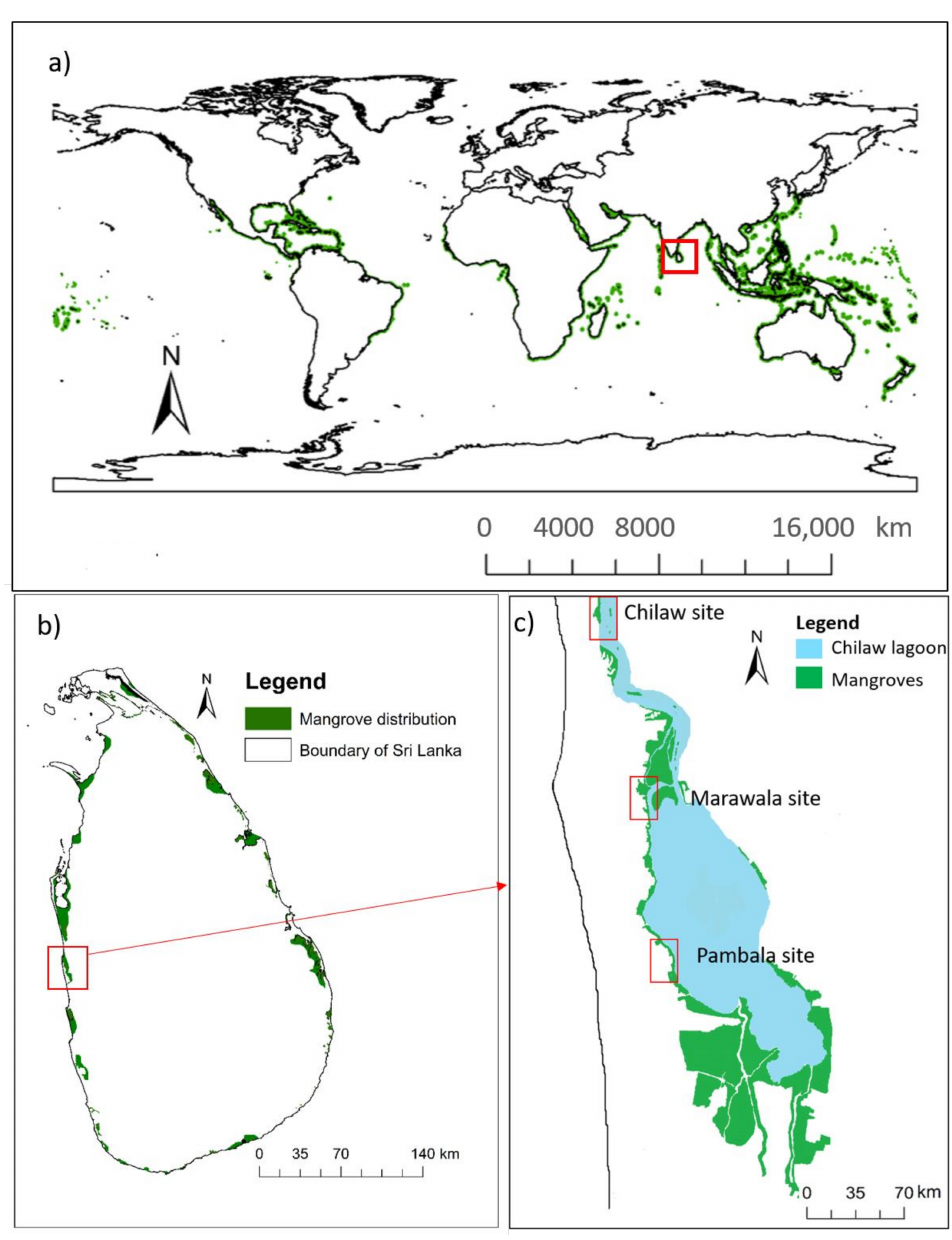
Figure 1. ( a ) Worldwide mangrove distribution [30] showing the location of Sri Lanka in the red colour square; ( b ) distribution of mangroves in Sri Lanka red square showing the location of Chilaw lagoon in North Western coast; and, ( c ) position of the three study sites along Chilaw